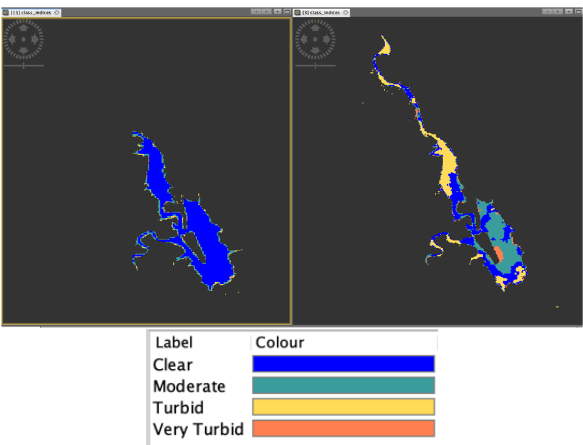
Figure 5. MSI vs. DESIS K-means clustering, Tous